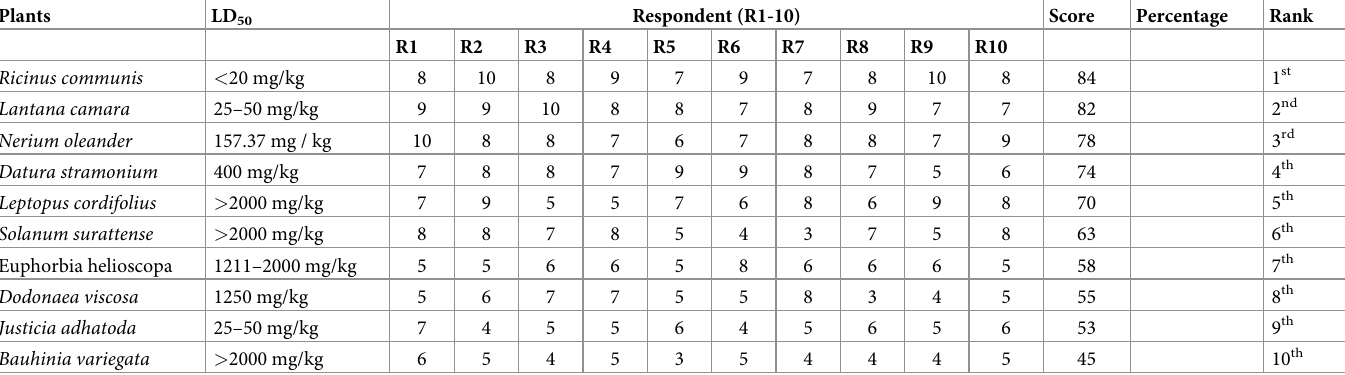
Table 6. The top ranked poisonous plants based on their LD50 and respondent scores.